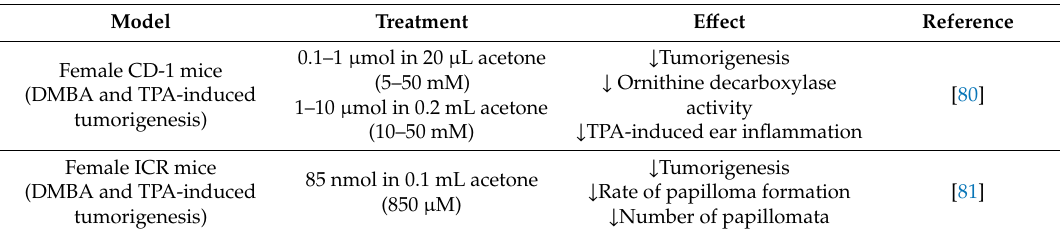
Table 10. E ff ects of carnosol on skin cancer in